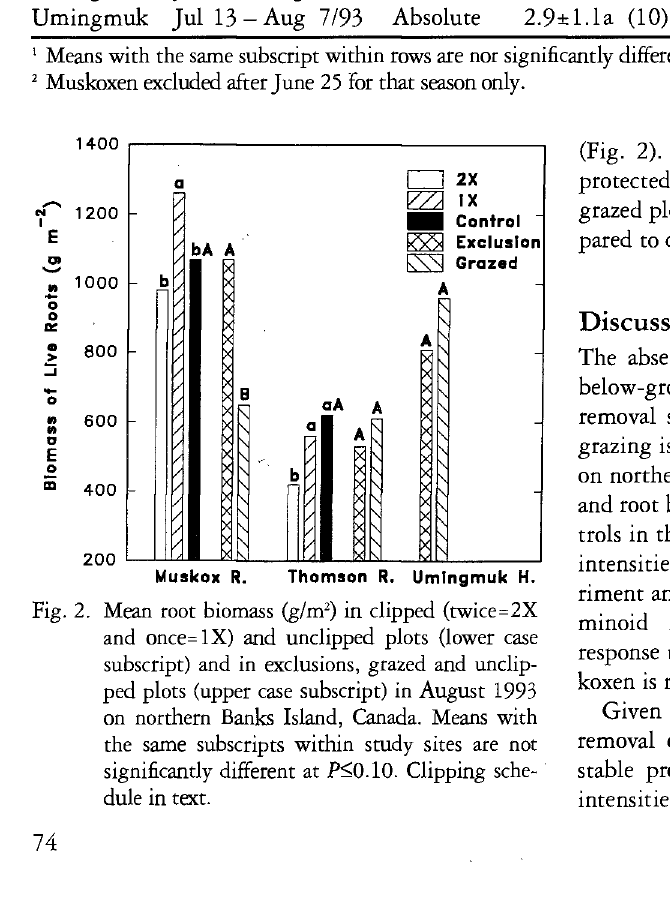
Fig. 2. Mean root biomass (g/m 2 ) in clipped (twice=2X and once = IX) and undipped plots (lower case subscript) and in exclusions, grazed and undip ped plots (upper case subscript) in August 1993 on northern Banks Island, Canada. Means with the same subscripts within study sites are not significantly different at P<0.10. Clipping sche dule in